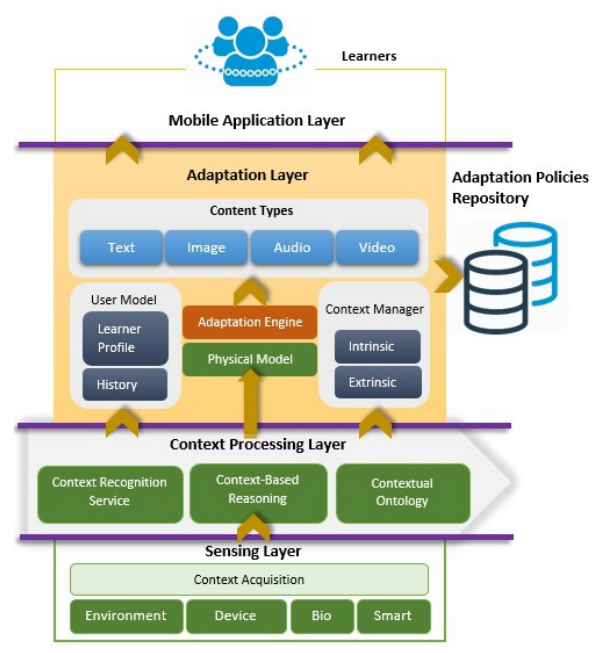
Figure 1. The AMBLE